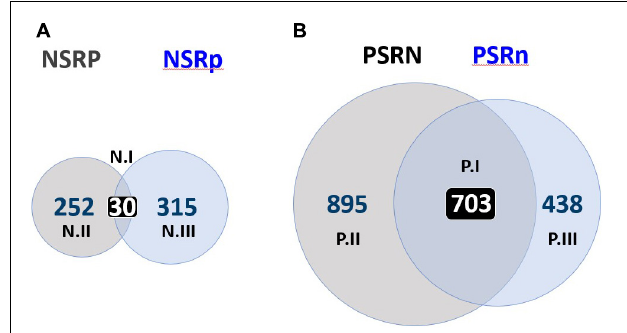
FIGURE 1 | Overview of gene expression changes under Nitrogen and Phosphate stress. Venn diagrams of genes that respond to nitrogen or phosphate stress in the presence or absence of the other stress. Stress responses are labeled by indicating primary nutrient comparison (i.e., NSR, nitrogen stress response or PSR, phosphate stress response) and then adding an upper- or lower-case letter for the other nutrient involved (i.e., NSRP for nitrogen stress response under high phosphate, NSRp for nitrogen stress response under low phosphate). (A) Venn diagram showing genes where mRNA abundance changed two-fold ( p ≤ 0.01) when comparing ammonia-grown cultures to glutamate–grown cultures under sufficient phosphate (gray = NSRP) and under limiting phosphate (blue = NSRp). (B) Genes where mRNA abundance changed two-fold ( p ≤ 0.01) when comparing 2 mM phosphate-grown cultures to 50 µ M phosphate-grown cultures with ammonium as nitrogen source (gray = PSRN) or glutamate as the nitrogen source (blue = PSRn). Each section of the Venn diagram is labeled with the cluster name as defined in Table 2 and the number of genes included in that